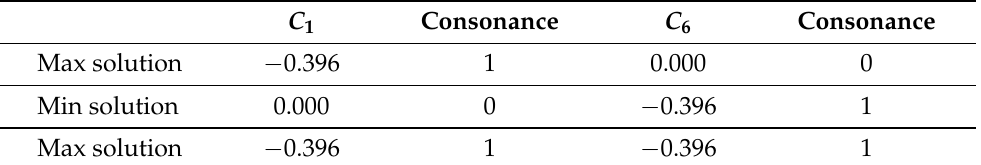
Table 9. Maximum and minimum solutions for the fuzzy cognitive map determining the grade of brain